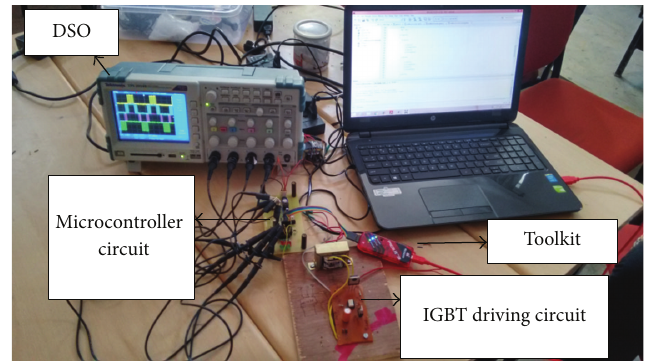
Figure 8: Photograph experimental setup.